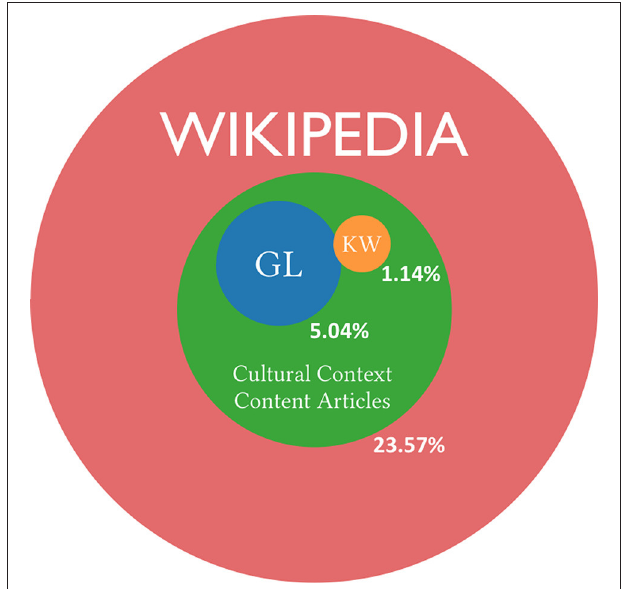
FIGURE 3 | Average proportion of CCC, and of CCC detected through geolocation and keywords. Sizes are in scale according to their